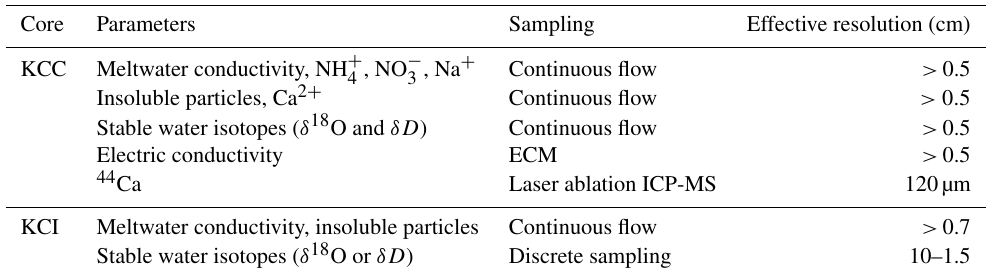
Table 2. Overview on ice core analyses and datasets used in this study.